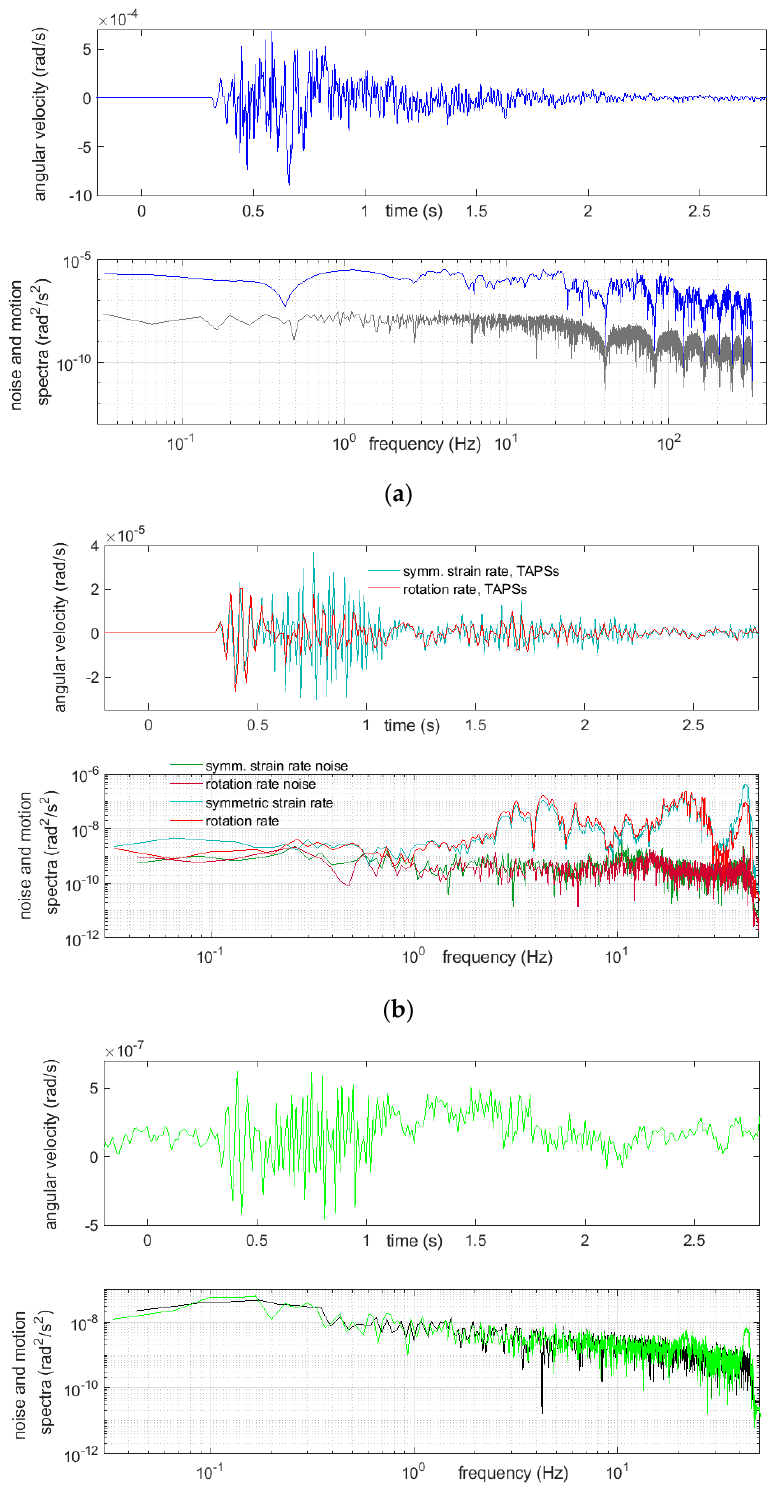
Figure 10. Recording of the solitary blast in the corridor, No. 48, on 26 April of 73 g of the explosive: ( a ) from FOSREM, the rotation rate and below its spectrum (blue), together with the rotational noise spectrum (gray), ( b ) from TAPSs, the symmetric strain rate (turquoise) and rotation rate (red) and below the spectra of these motions, together with adequate noise spectra and ( c ) from the CZ sensor, the rotation rate and below its noise (green), together with the rotational noise spectrum